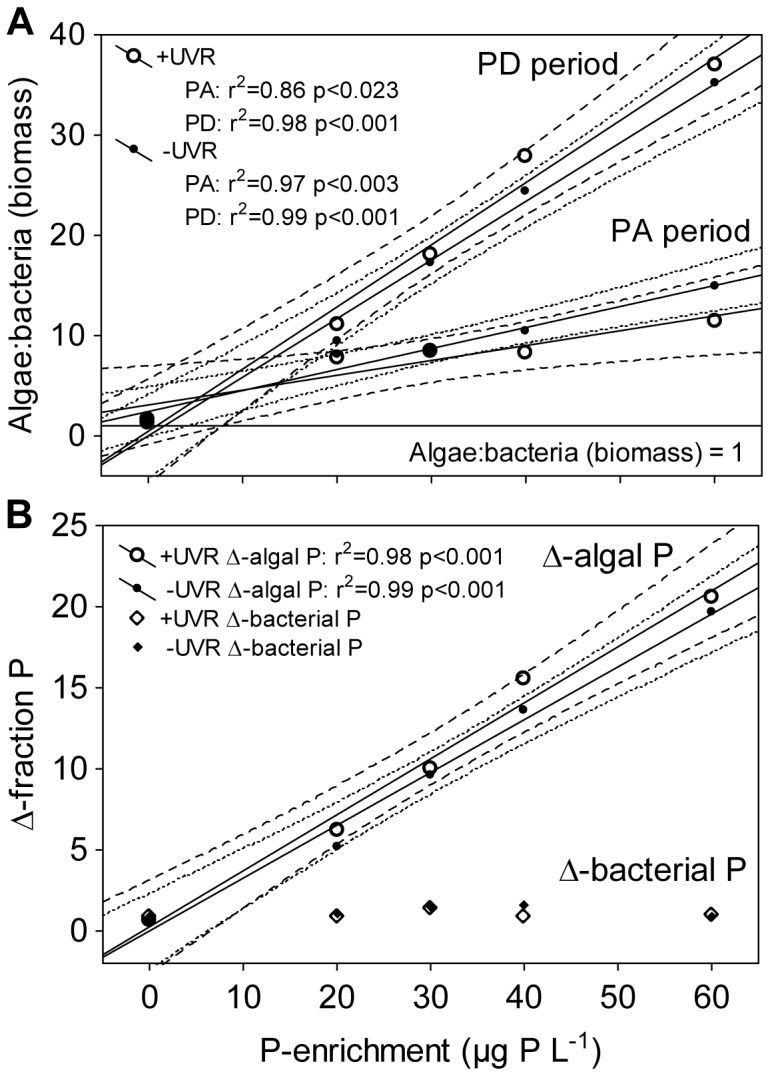
Linear regressions between structural variables and P enrichment.(A) algae:bacteria ratio (biomass) vs. P enrichment under +UVR and –UVR conditions in the PA and PD periods; (B) Δ-algal P or Δ-bacterial P vs. P enrichment under +UVR and –UVR conditions in the PD period. Dashed and dotted lines indicate 95% interval confidence for each regression. (PA period: phosphorus-availability period; PD period: phosphorus-depletion period).